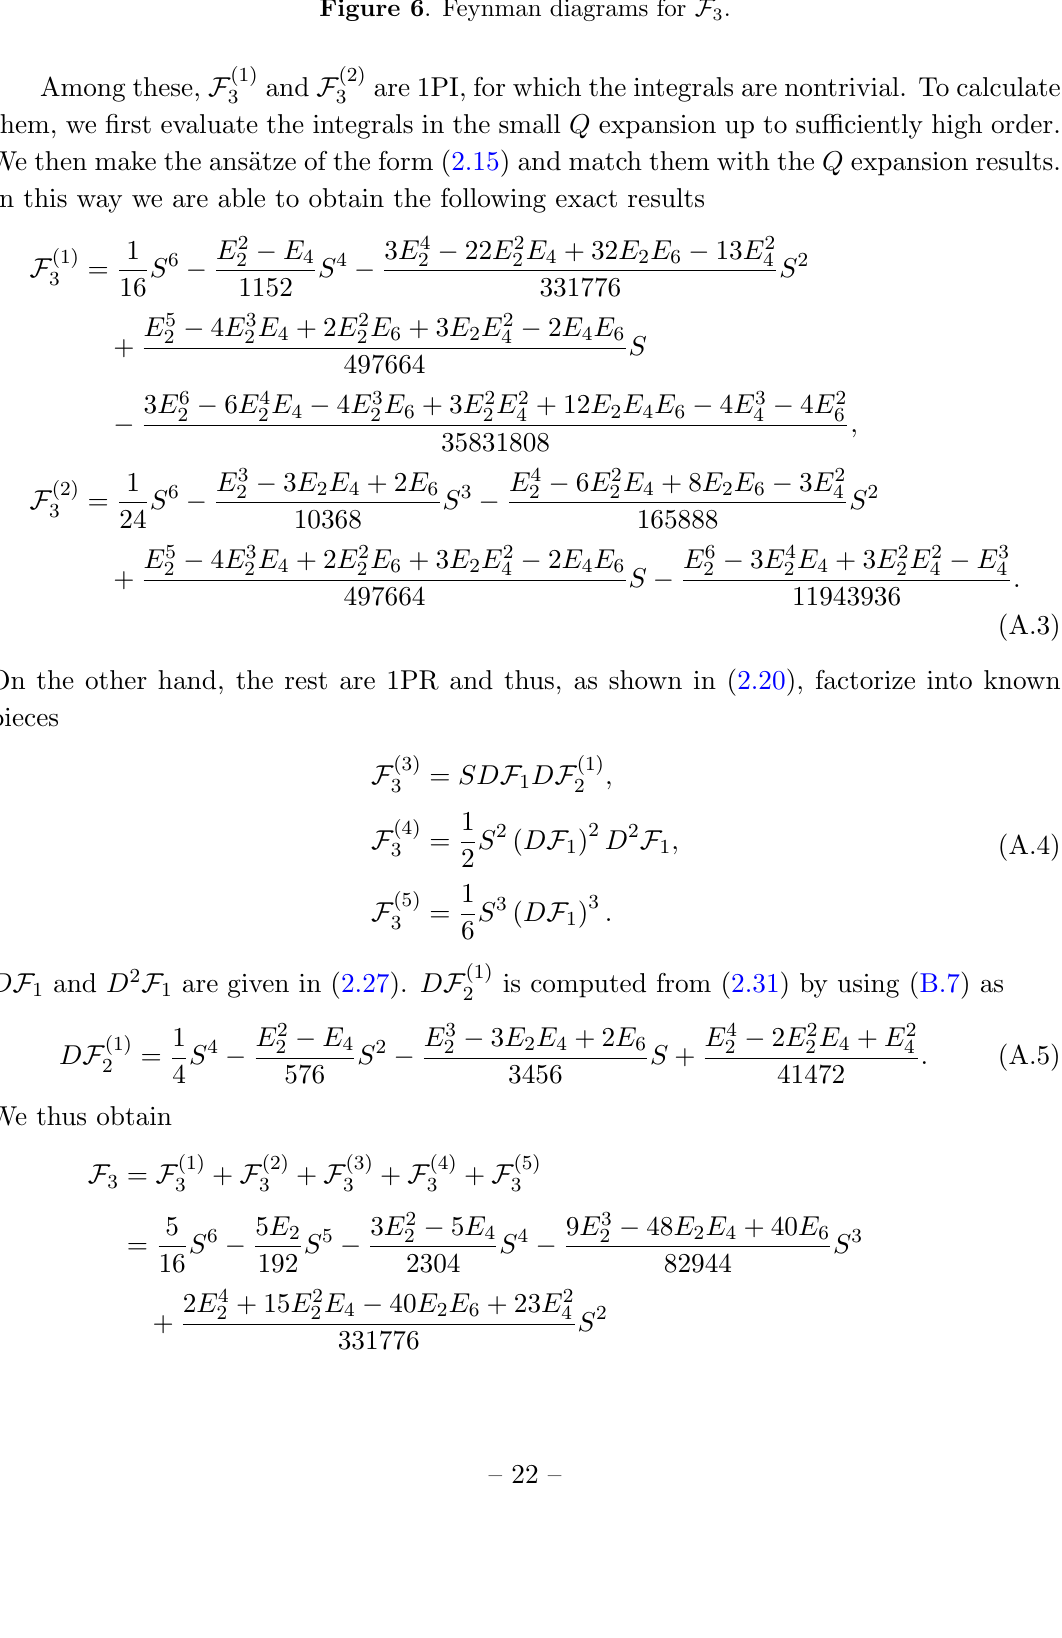
Figure 6 . Feynman diagrams for